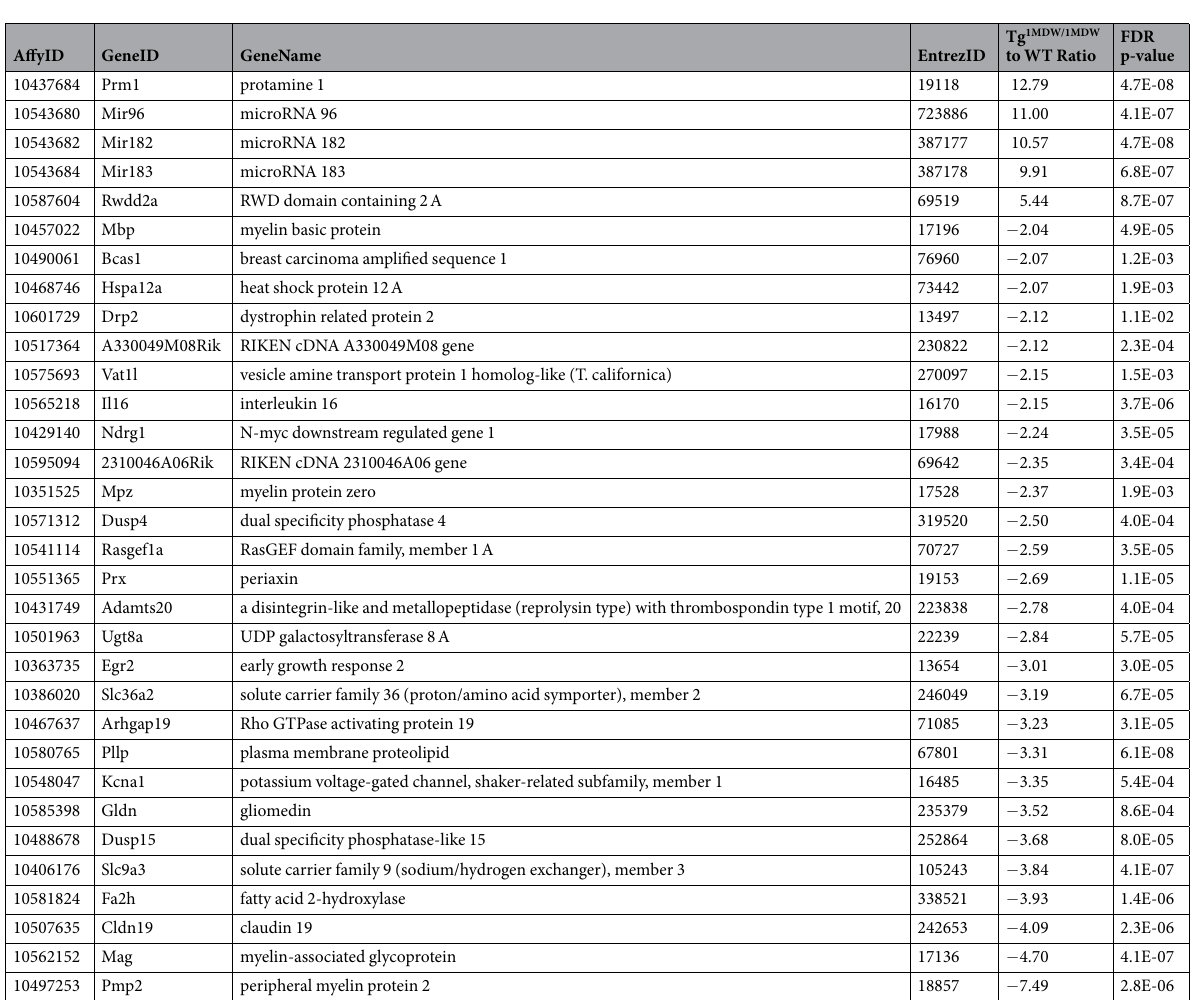
Table 2. List of 32 significantly changed Tg 1MDW/1MDW Affymetix probesets in the P5-OC. From a total of 28,188 annotated probesets using the Limma Package and MicroArraysRUS Gui interface to R and Bioconductor microarray analysis programs.